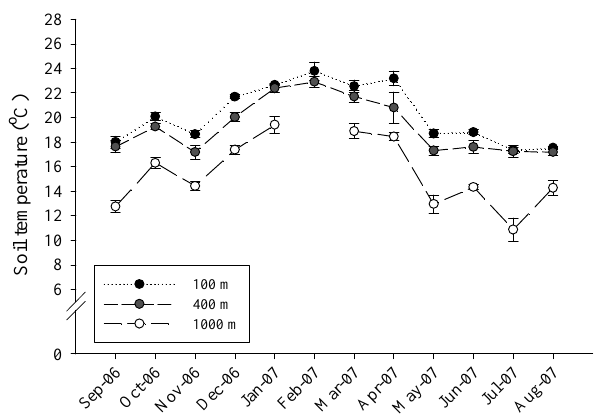
Fig. 2. Monthly variation of Water Filled Pore Space (WFPS) at different elevations. Values represent means of four replicates per elevation and bars represent standard errors. Because of weather conditions it was not possible to access the sites at altitude 1000 m in February 2007.